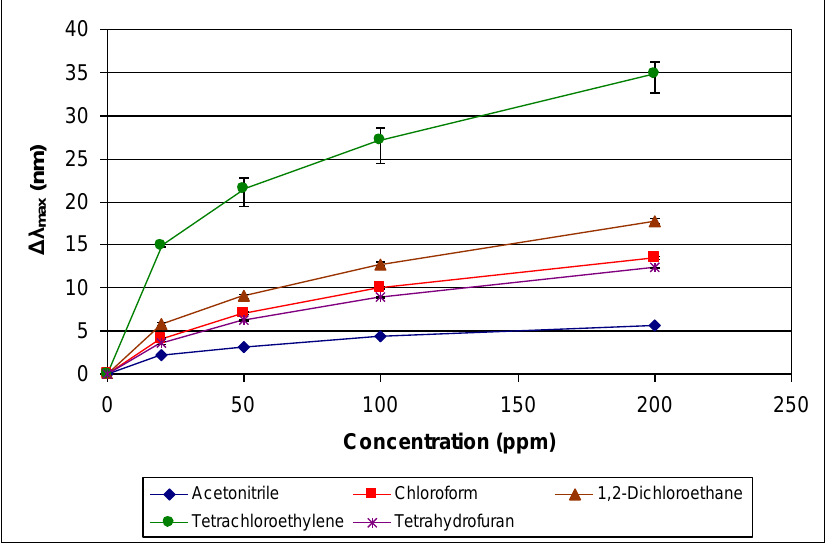
Figure 10. Response of sensor to several organic vapors at various concentrations.